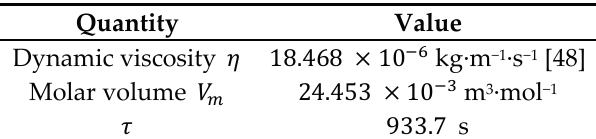
Table 1. Values for (cid:2015) and calculated (cid:1848) (cid:3040) and (cid:2028) (time constant) of air for (cid:1846) = 298 K (25 °C) and (cid:1868) = 1013.25 hPa